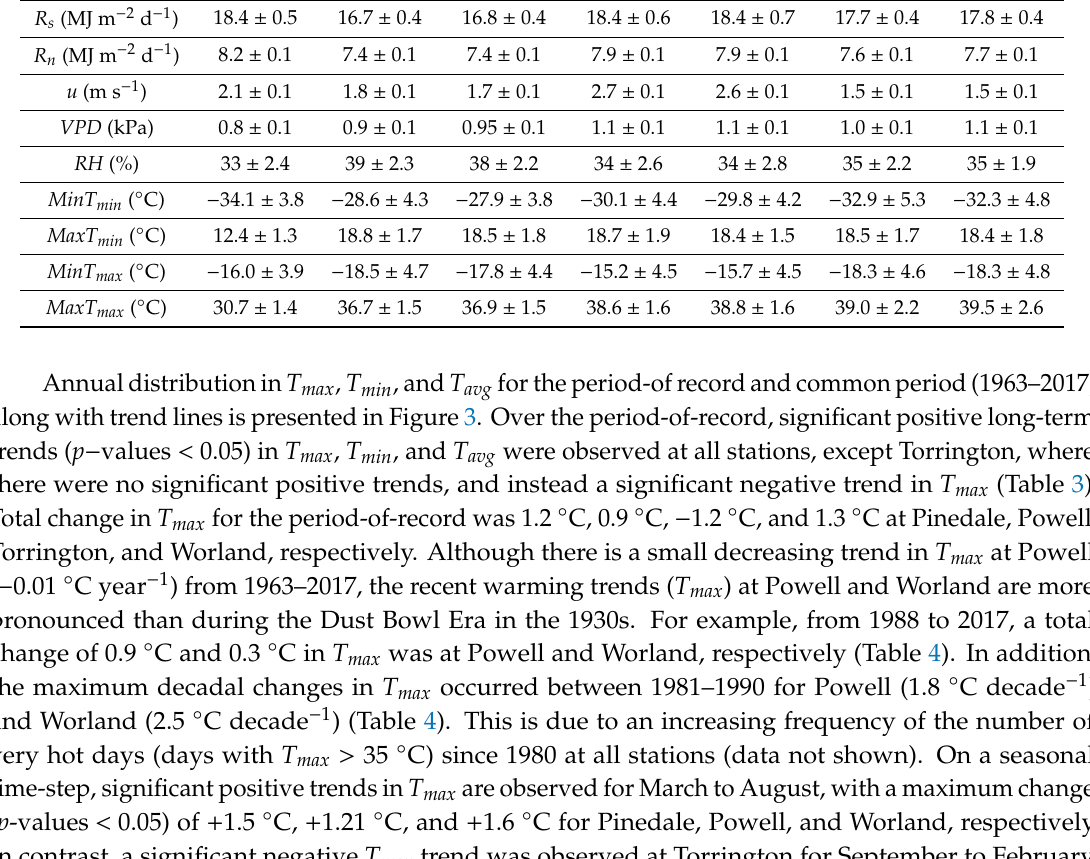
Variable Pinedale Powell Torrington Worland Time